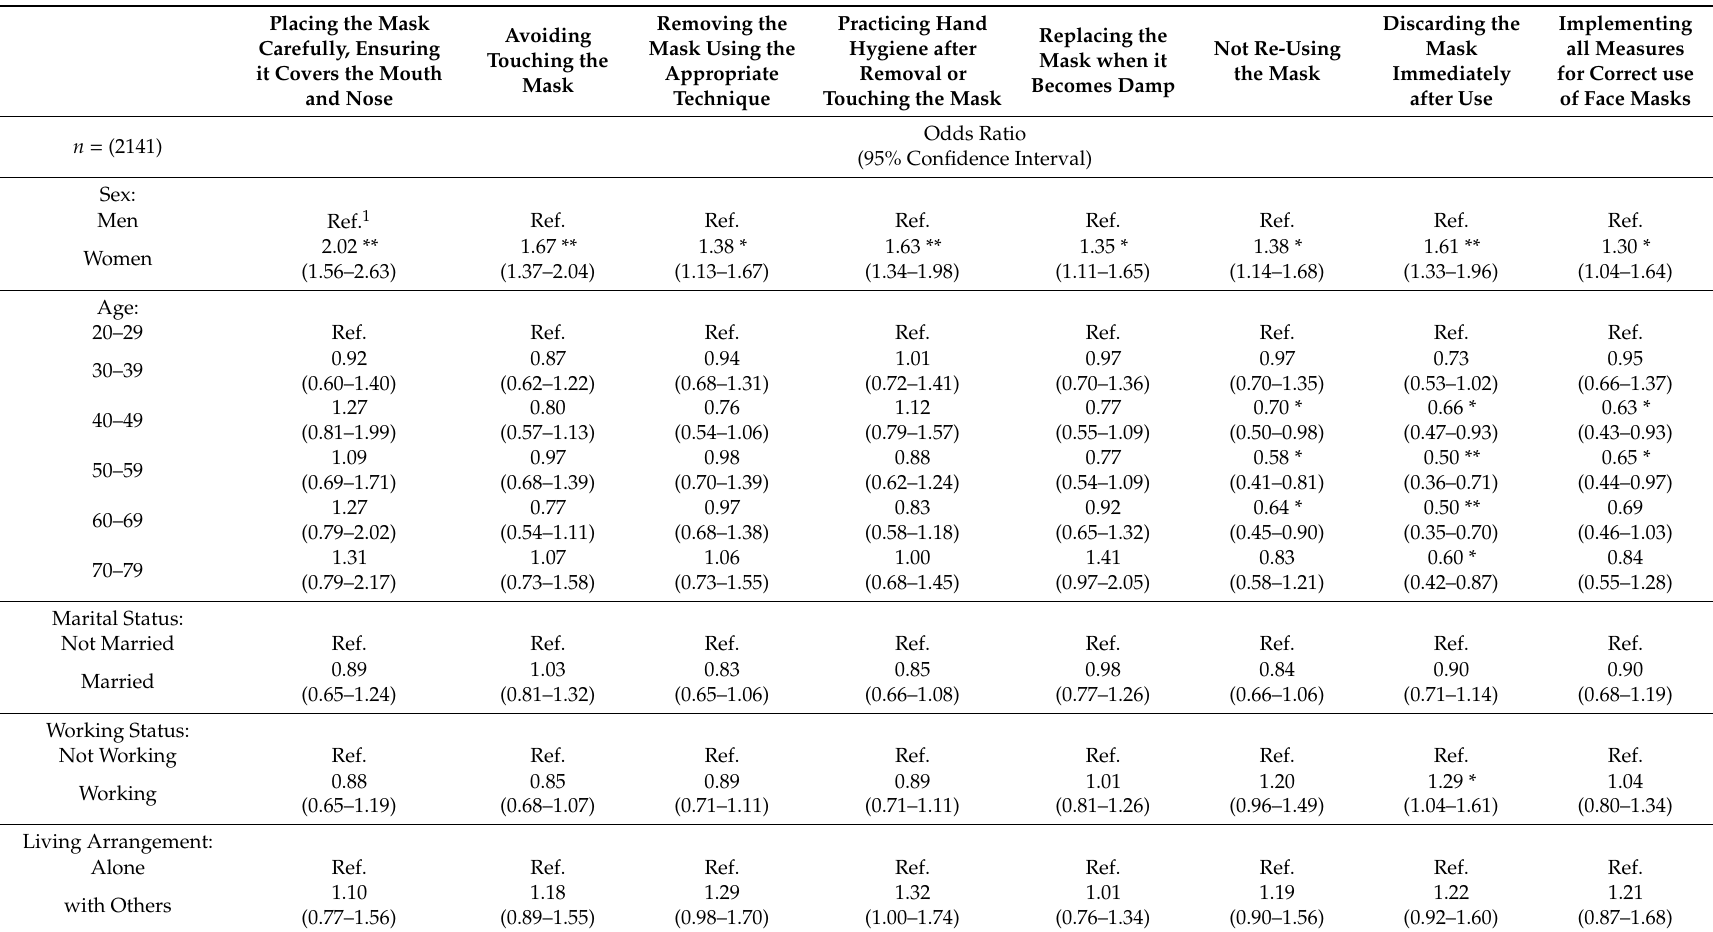
Discarding the Implementing Not Re-Using Mask all Measures the Mask Immediately for Correct use after Use of Face Masks